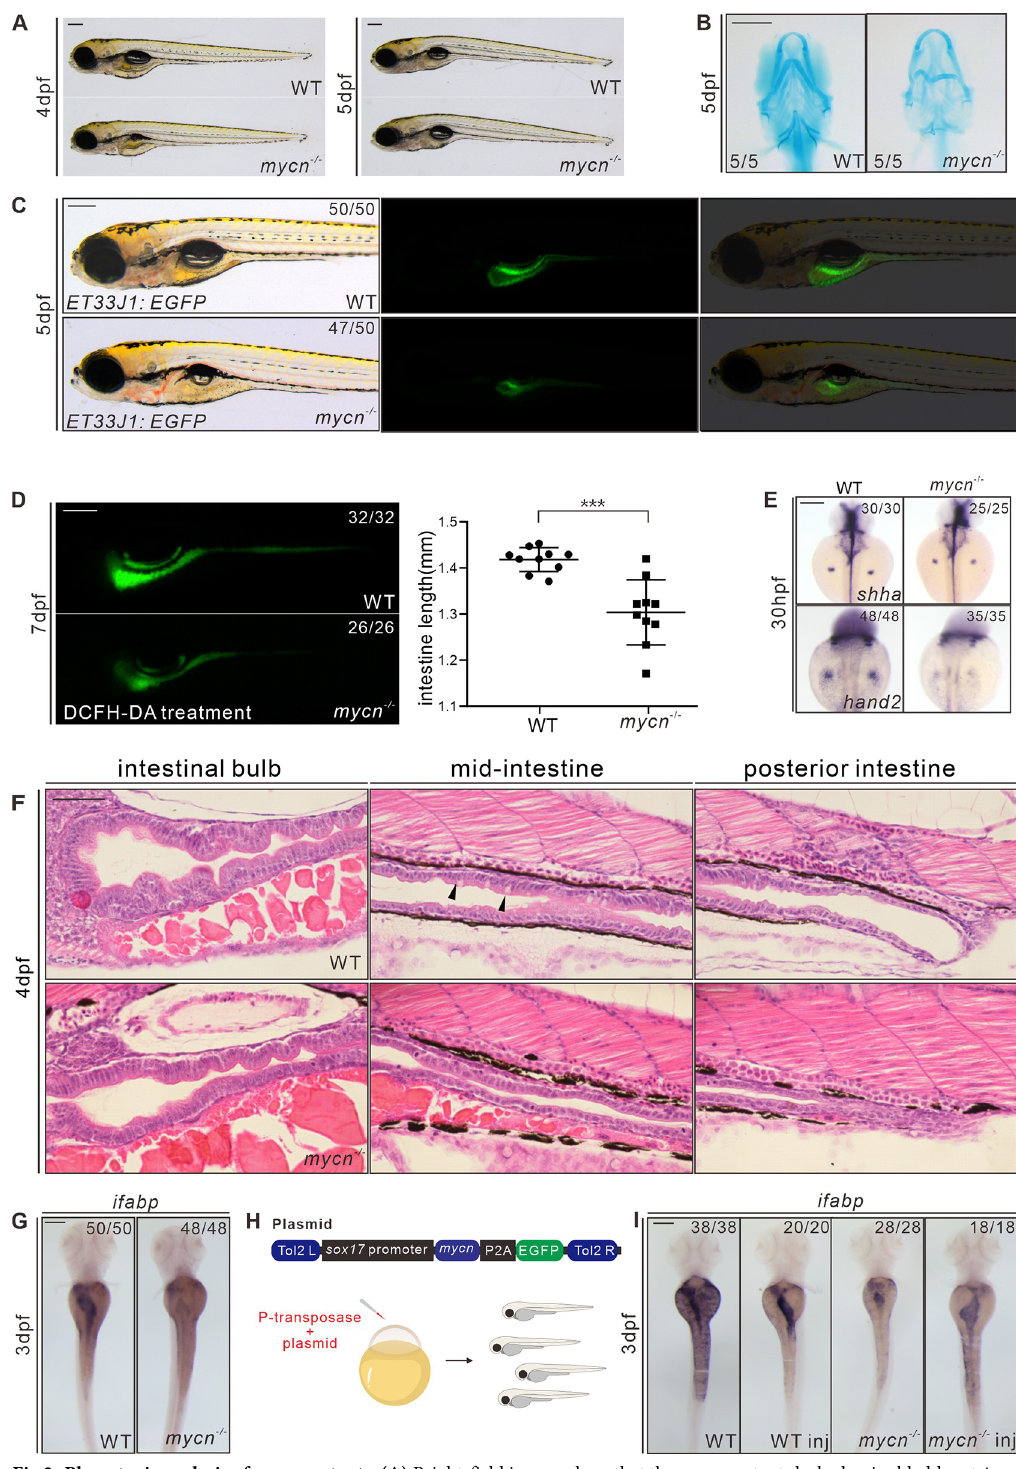
Fig 2. Phenotypic analysis of mycn mutants. (A) Bright-field images show that the mycn mutants lacked swim bladder at 4 dpf but appeared at 5 dpf. All embryos are shown in lateral view. (B) Abnormal pharyngeal arch development was observed in mycn mutants via Alcian blue staining; images show the head region of WT and mycn mutant embryos at 5 dpf (ventral view). (C) Intestinal lumens in WT and mycn mutant embryos at 5 dpf shown by ET33J1 : EGFP reporter (lateral view). (D) Fluorescence signals show the morphology of the whole intestines in WT and mycn mutant embryos at 7 dpf via